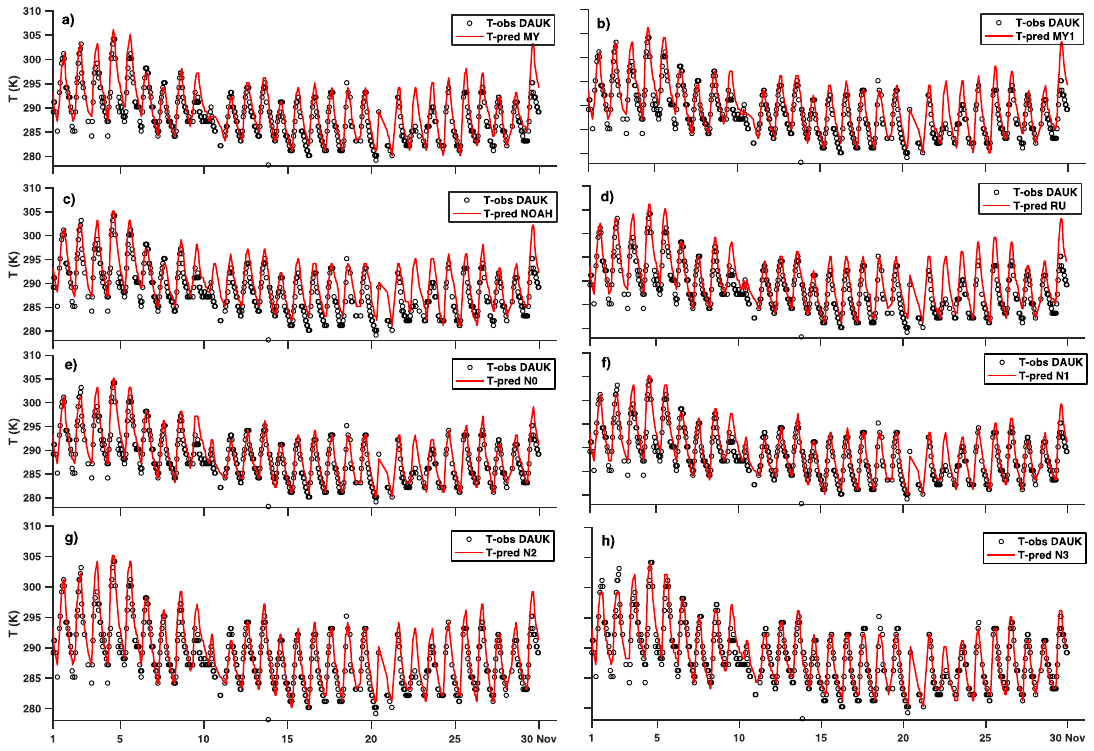
Figure 4. Time series of temperature (T) observed at DAUK meteorological station versus T predicted by MY ( a ), MY1 ( b ), NOAH ( c ), RU ( d ), N0 ( e ), N1 ( f ), N2 ( g ), and N3 ( h ) simulations.